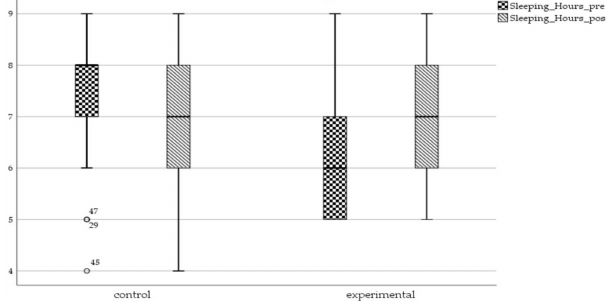
Figure 2. Box whisker graphic of sleeping hours in control and experimental groups in pre- and post-treatment phases.